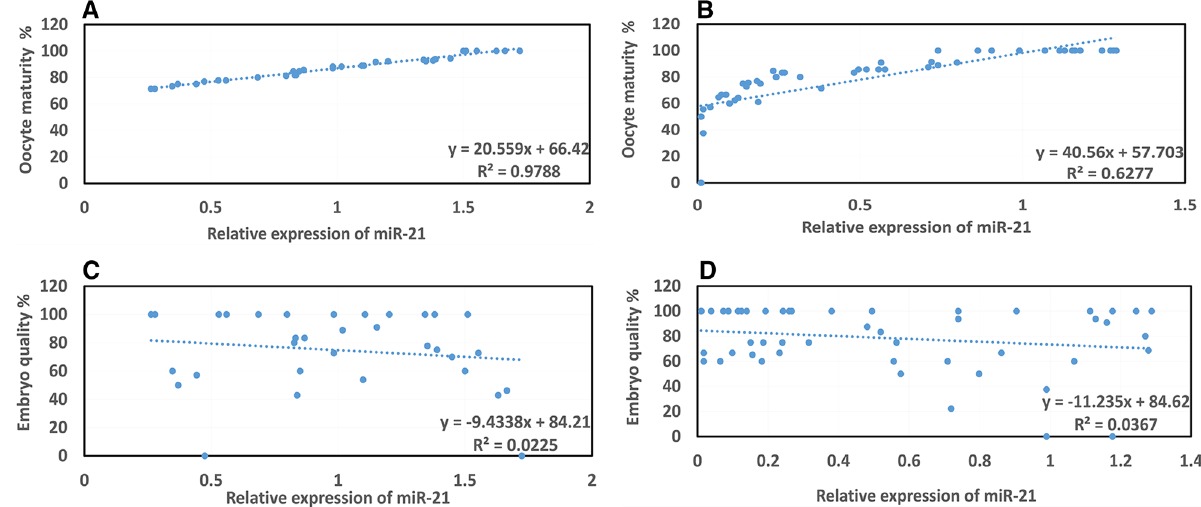
Figure 5. Correlation of the level of miR-21 expression in the cumulus cells (CCs) with oocyte maturation (%) and embryo quality (%) in the case and control groups. The rate of miR-21 expression in the CCs was directly related to the oocyte maturation based on Pearson’s correlation ( p < 0.05). There was no significant relationship between the rates of miR-21 expression in the CCs and embryo quality based on Pearson’s correlation ( p > 0.05). The results are presented as the mean ± SEM. ( A ) Correlation of the level of miR-21 expression in the CCs sample with oocyte maturation in the control group. ( B ) Correlation of the level of miR-21 expression in the CCS sample with oocyte maturation in the case group. ( C ) Correlation of the level of miR-21 expression in the CCs sample with embryo quality in the control group. ( D ) Correlation of the level of miR-21 expression in the CCs sample with embryo quality in the case